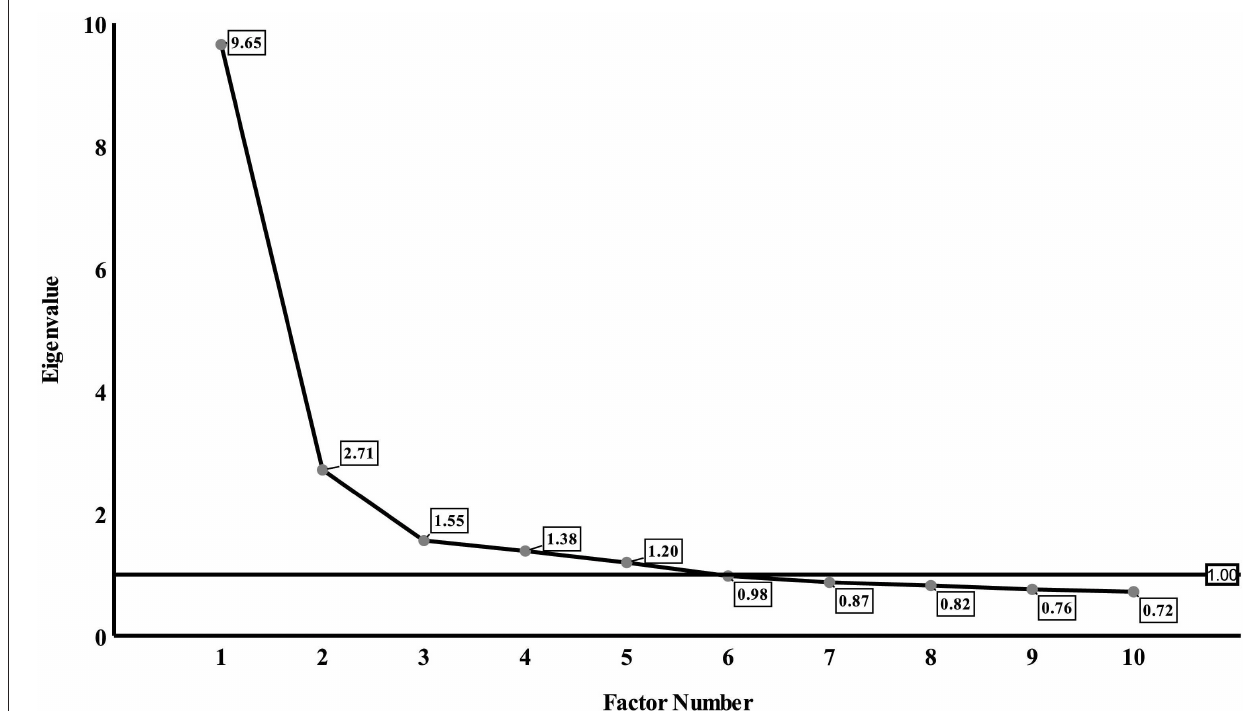
FIGURE 1 | Eigenvalue of factors on scree plot. The horizontal axis of the scree plot is the number of factors, and the vertical axis is the eigenvalue of factors. Five factors had eigenvalues of more than 1.